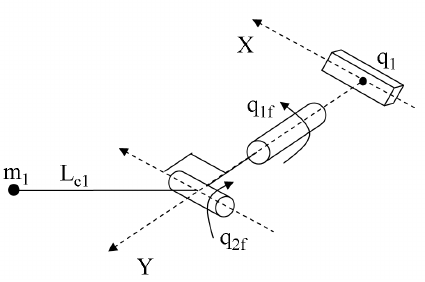
Figure 8: A prototype of the Gantry-Tau with a triangular-mounted link pair built at the Uni- versity of Agder.